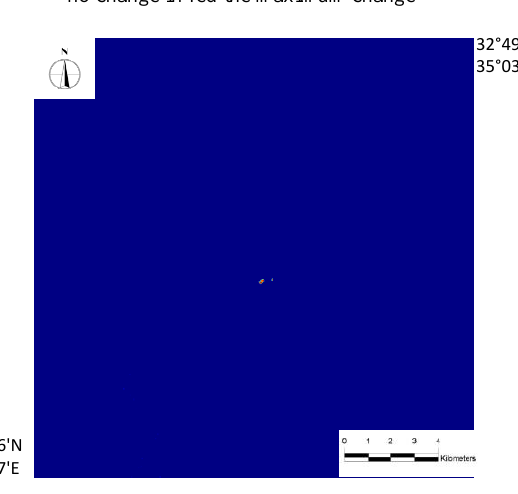
Figure 4. VDI change detection map calculated by Landsat OLS8 multispectral pan-sharpen bands between day number 289 and day number 329 (during the fire event in Haifa) in blue no change in red the maximum change